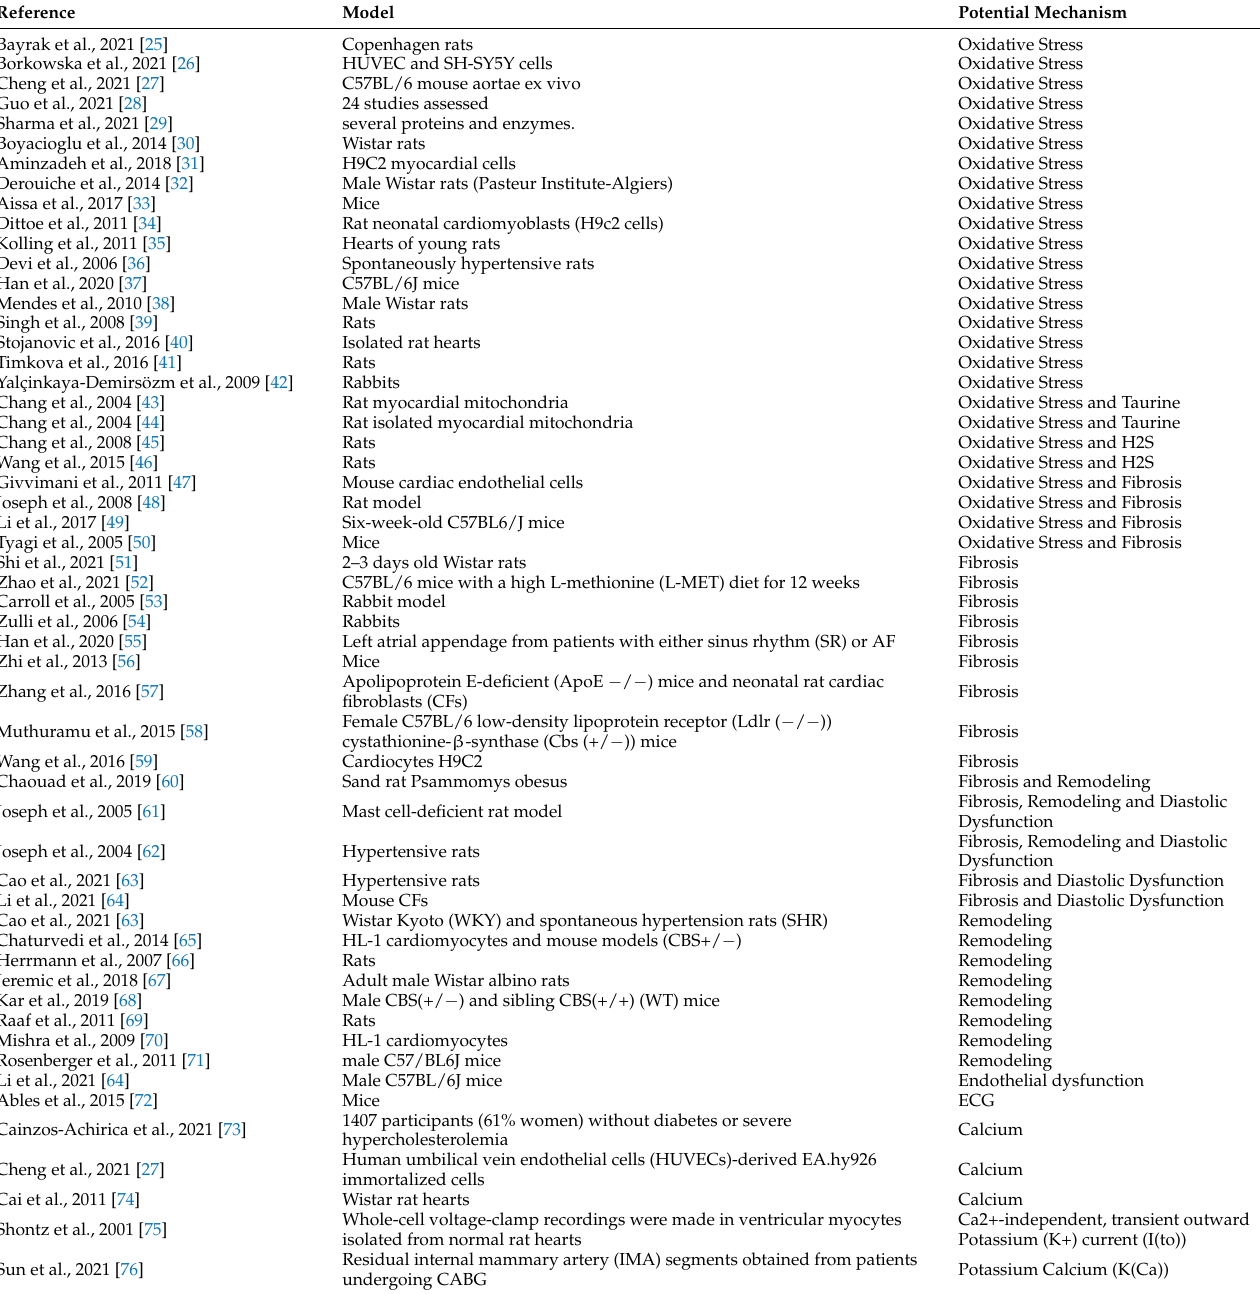
Table 2. Table presenting the outline of studies included in the scoping